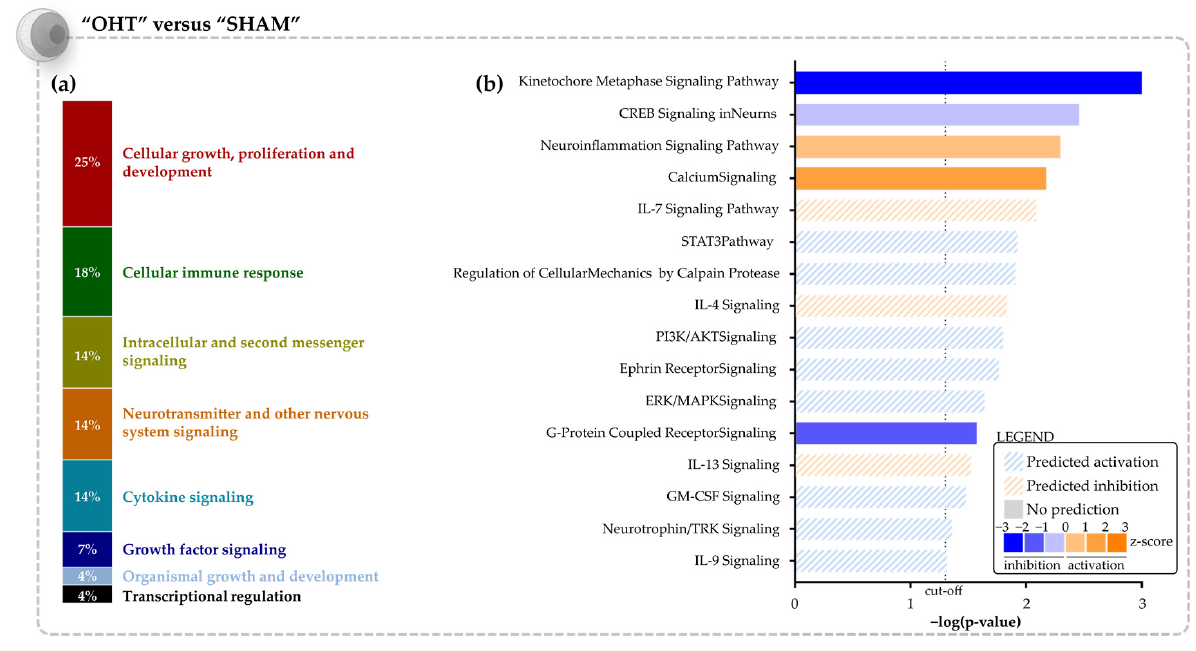
Figure 4. Canonical Pathway analysis in the glaucomatous RGC transcriptome (“OHT” vs. “SHAM” RGCs). ( a ) Overarching categories to which the altered canonical pathways belong. ( b ) List of altered signaling pathways relevant to the biological question (FDR ≤ 0.1, − log ( p -value) ≥ 1.30, Fisher’s exact test). A list of all significantly altered canonical pathways is provided in Supplementary File S2. IPA predictions are algorithm- (based on z-score, filled bars) or user-defined (striped bars). Pathways that are predicted to be upregulated are shown in orange, those predicted downregulated in blue. Table 1. Upstream regulators identified as significantly inhibited in the “OHT” RGCs as compared